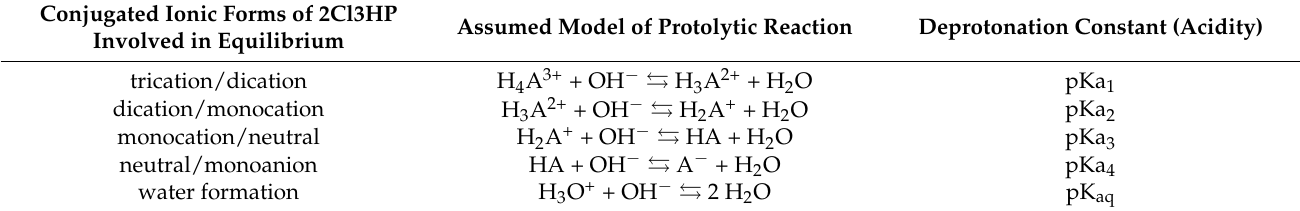
Table 3. Proposed deprotonation equilibria model used for aqueous systems studied in calculations (potentiometry and spectrophotometry) and DFT approach; 2Cl3HP neutral form was assigned as a